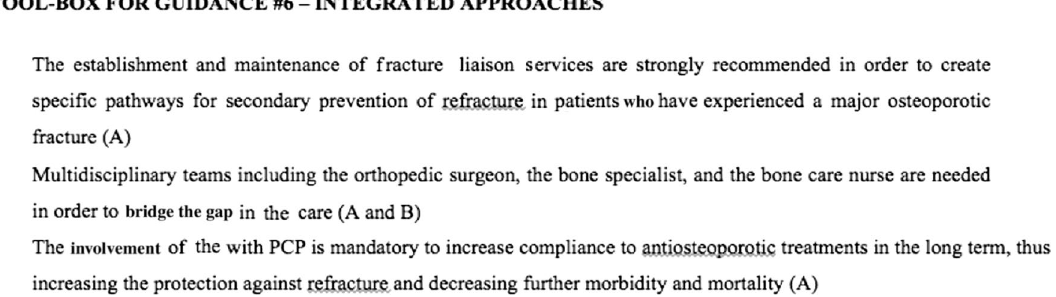
Fig. 8 Toolbox for guidance: integrated